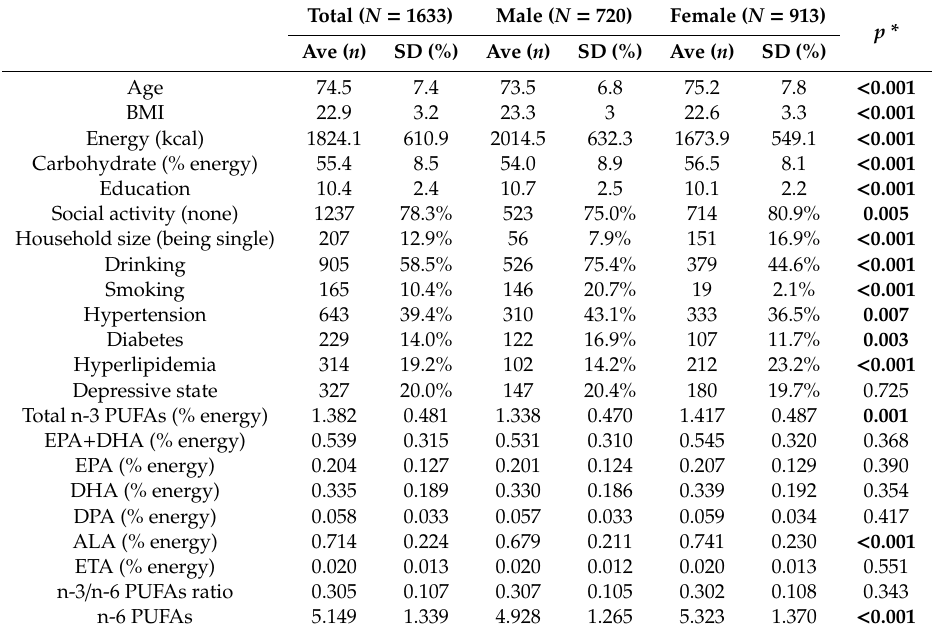
Table 1. Participant